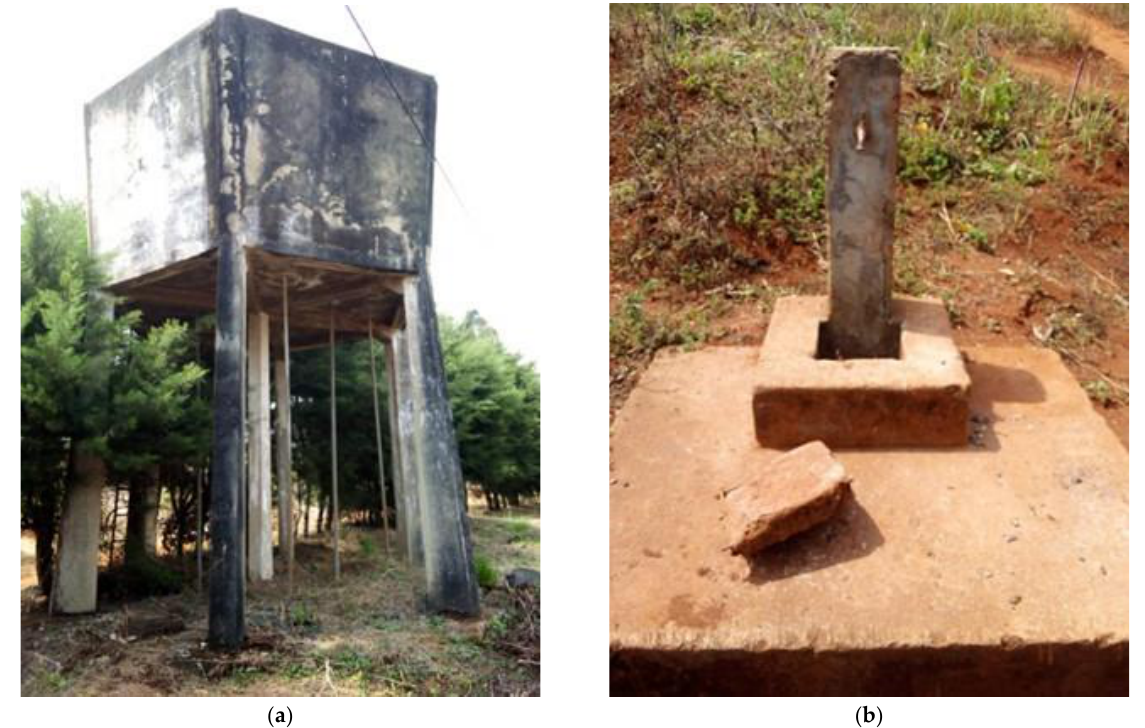
Figure 6. Photograph of the water tower ( a ) and a standpipe ( b ) in Feutap 2. Own photograph, 9 January 2022.